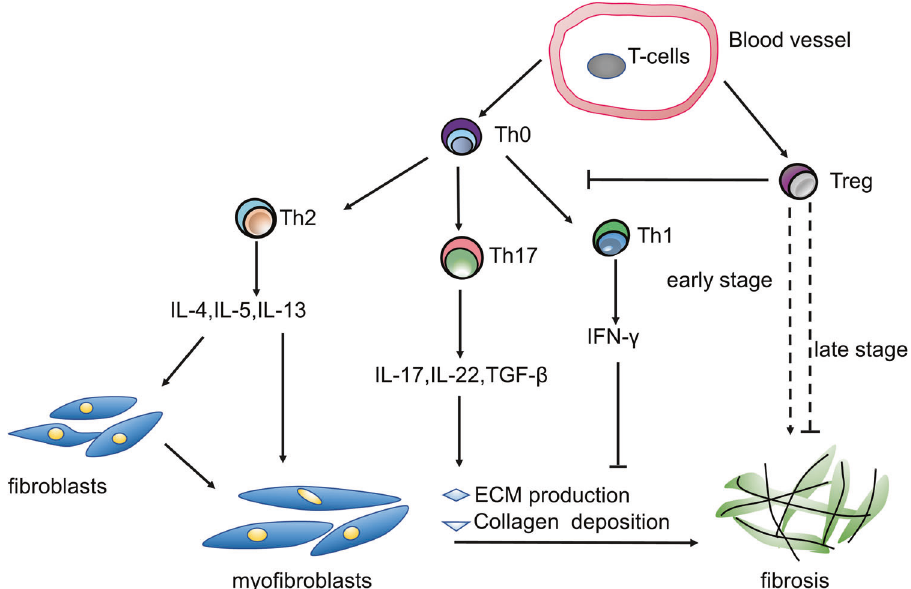
Fig. 1 Graphic illustration of important T-cell subtypes in IPF. When the immune system is stimulated by external risk factors, T cells migrate to the interstitium and play different roles as a result of various secreted chemokines. Th1 cells are anti fi brotic due to the suppressor IFN- γ . Th2 cells can activate fi broblasts and myo fi broblasts. IL-17 produced by Th17 cells extensively promotes ECM production and collagen deposition. Tregs inhibit immunoreaction and may have opposing functions in the early and late stages of fi brosis. Th T helper cell, Treg regulatory T-cell, TGF transforming growth factor, IFN interferon, ECM extracellular